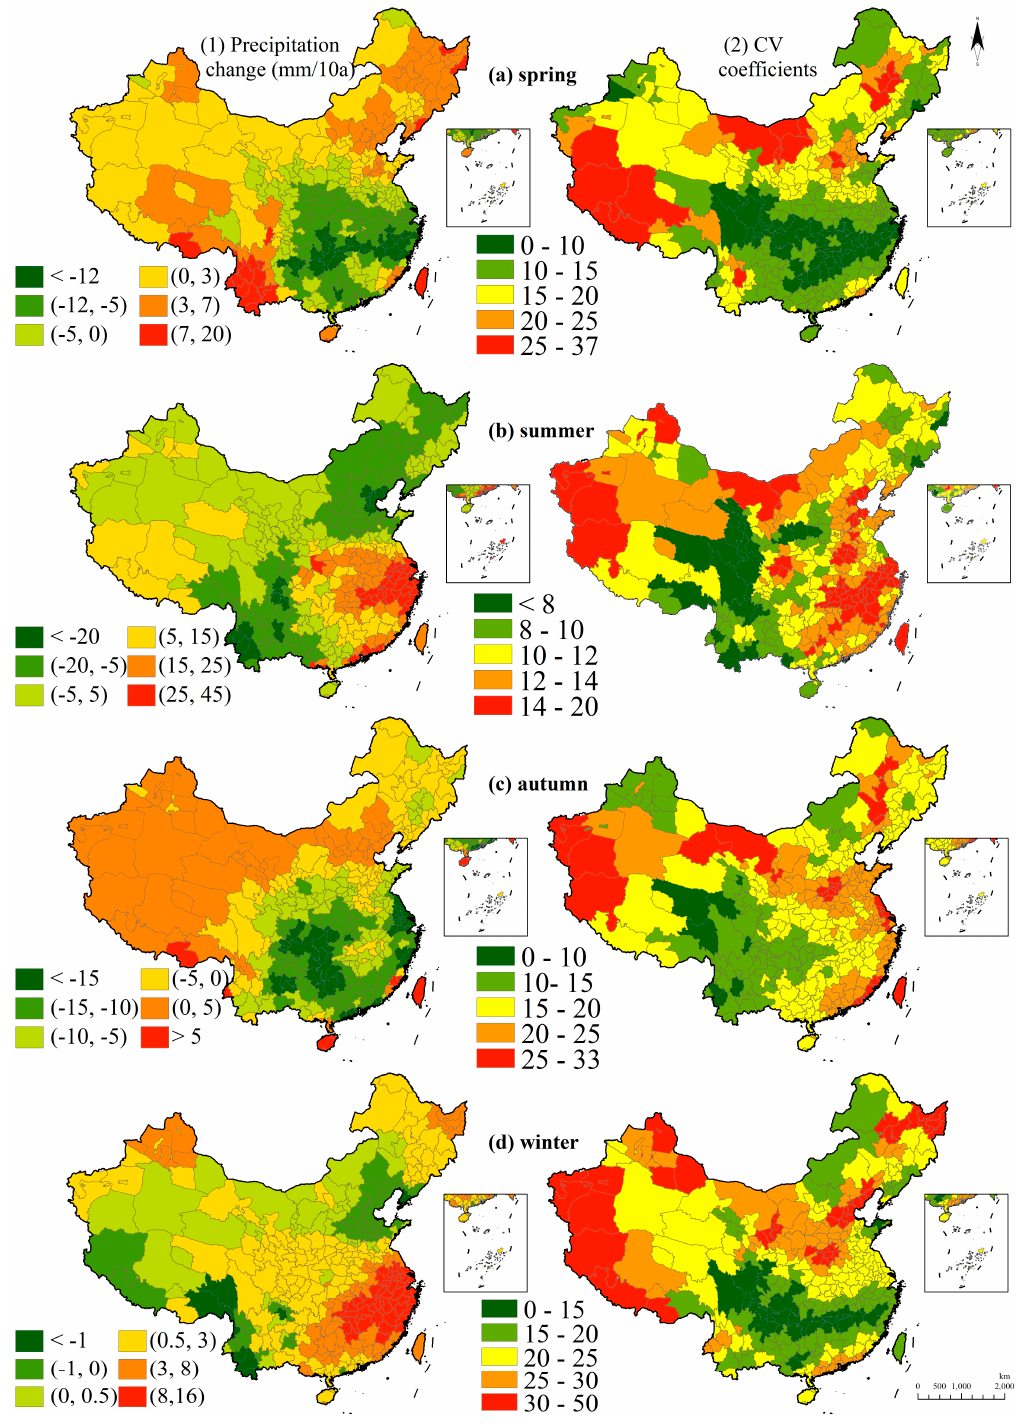
Figure 7. Seasonal precipitation changes and fluctuations in 60 years. Note: ( a1 ) is for the precipitation change in the spring and ( a2 ) is the CV coefficient. For the same outcome, ( b – d ) are corresponding to the precipitation change and the CV coefficient in the summer, autumn, and winter.